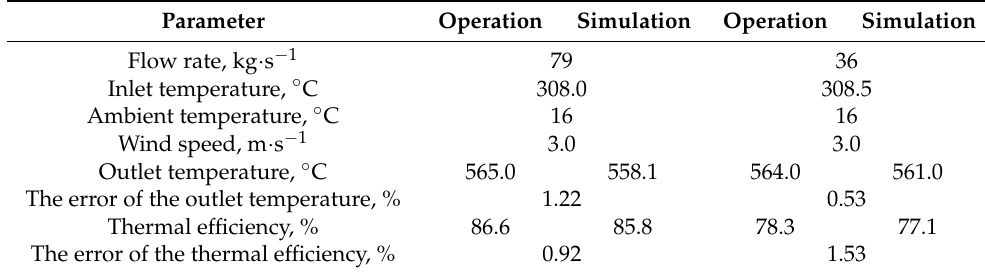
Table 2. The comparison of the simulation results and test